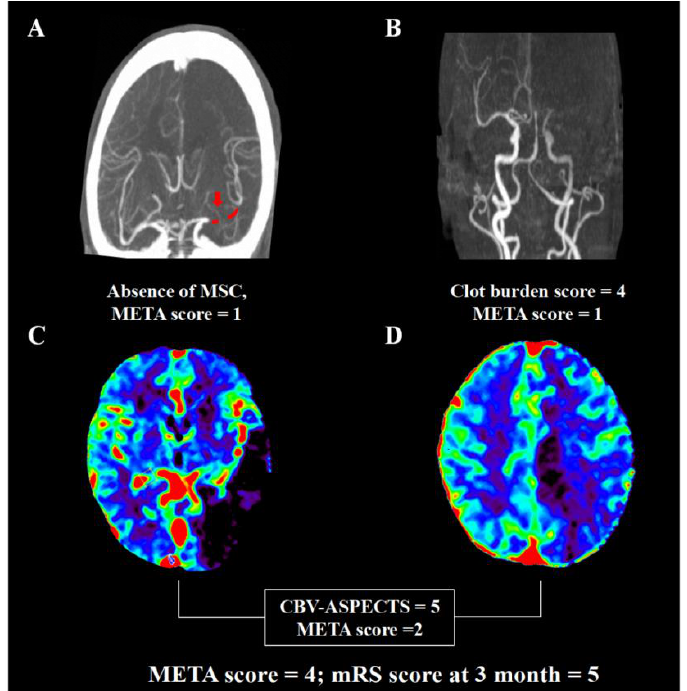
Figure 2. Representative images for calculation of META. A male patient had occlusion of left middle cerebral artery on dynamic computed tomography angiography ( A , B ). He had clot burden score of 4 (occlusion of M1 and M2), one segment of clot (red dot that the red arrow points to, ( A )), good collateral with >50% filling of the occluded middle cerebral artery territory ( A ). Cerebral blood volume map ( C , D ) demonstrated the Alberta Stroke Program early CT score of 5. Thus, the META score was 4. The modified Rankin score was 5 at 3 months despite successful recanalization.